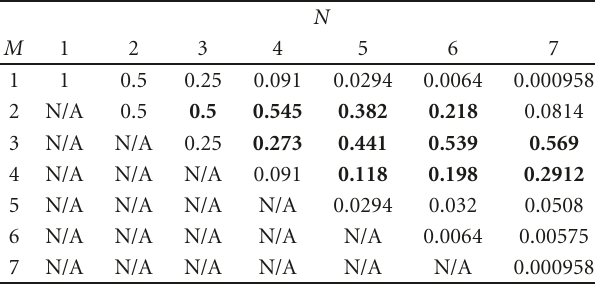
Table 2: The probability of a nonisomorphic graph using M resource units in N MBS Zones, P M , N .